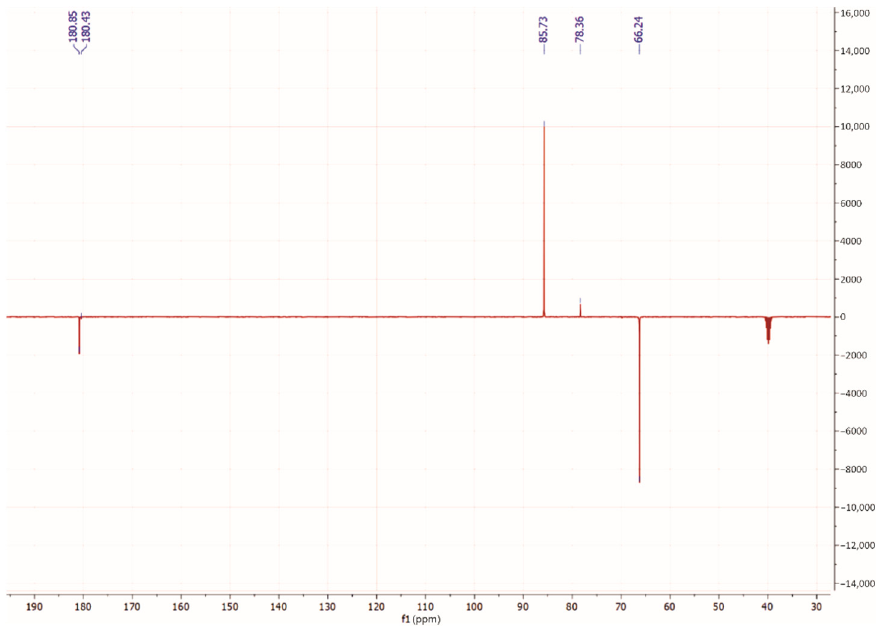
Figure 1. APT spectrum for 4,5-dihydroxy-1,3-bis(hydroxymethyl)imidazolidine-2-thione 6.